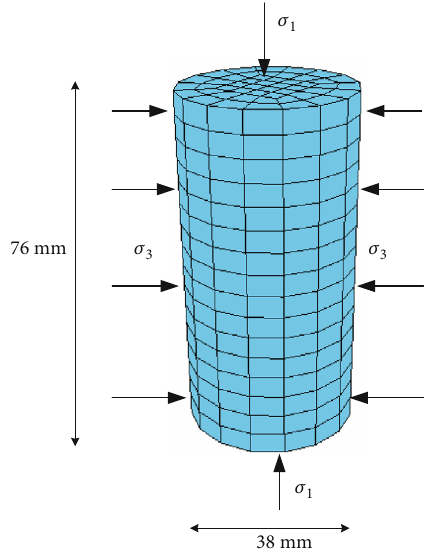
Figure 6: Geometrical model for triaxial